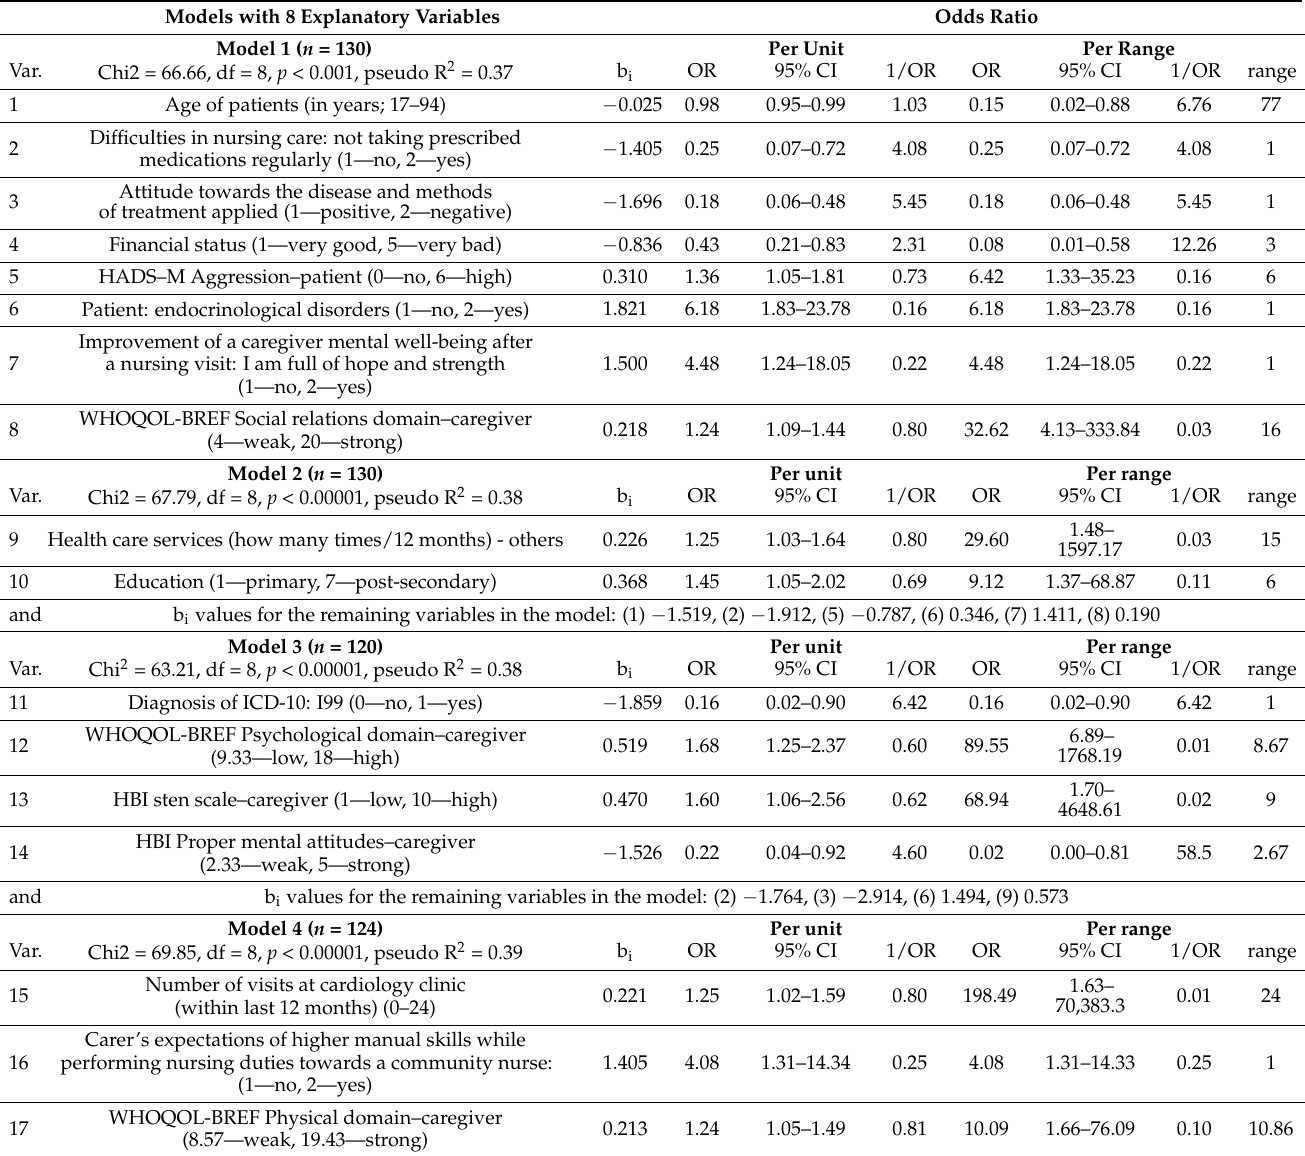
Table 2. The results of the logistic regression analysis and the odds ratio of the logistic regression model in the group of urban residents. Explained variable: effectiveness of health care (0—if a patient belongs to a group with LEHC; 1—if a patient belongs to a group with